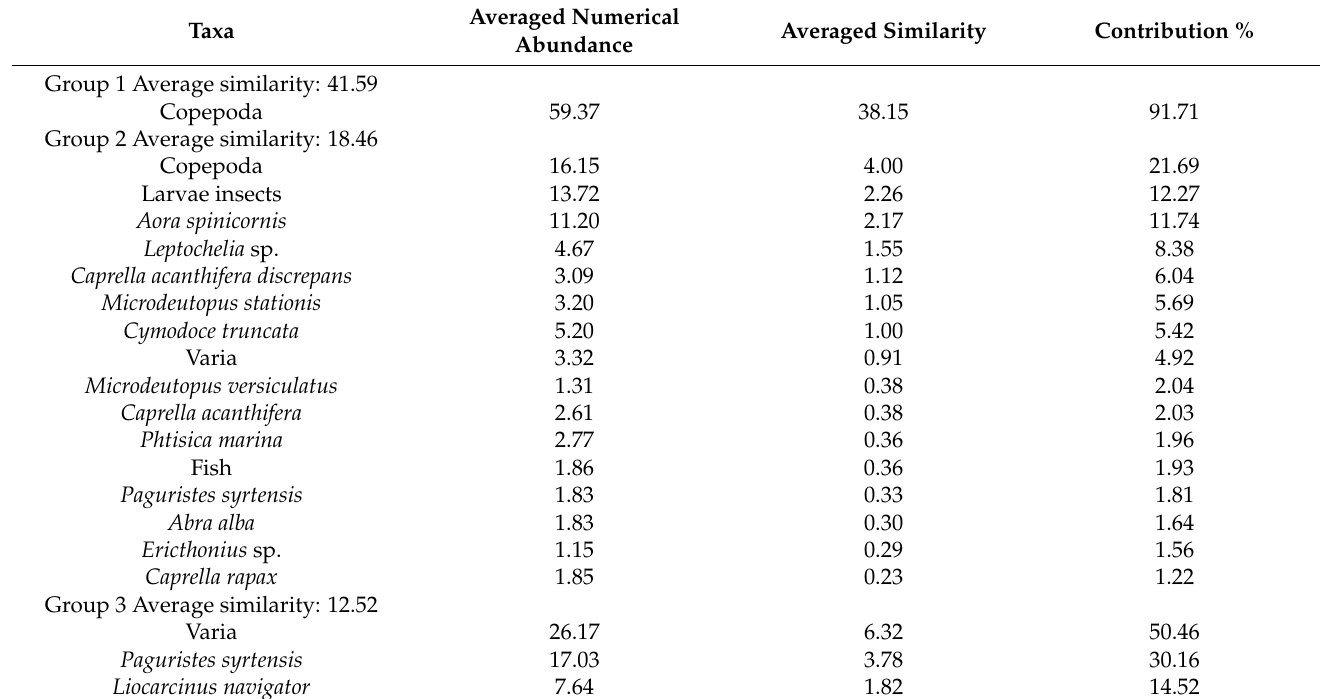
Table 2. Results of SIMPER analysis.